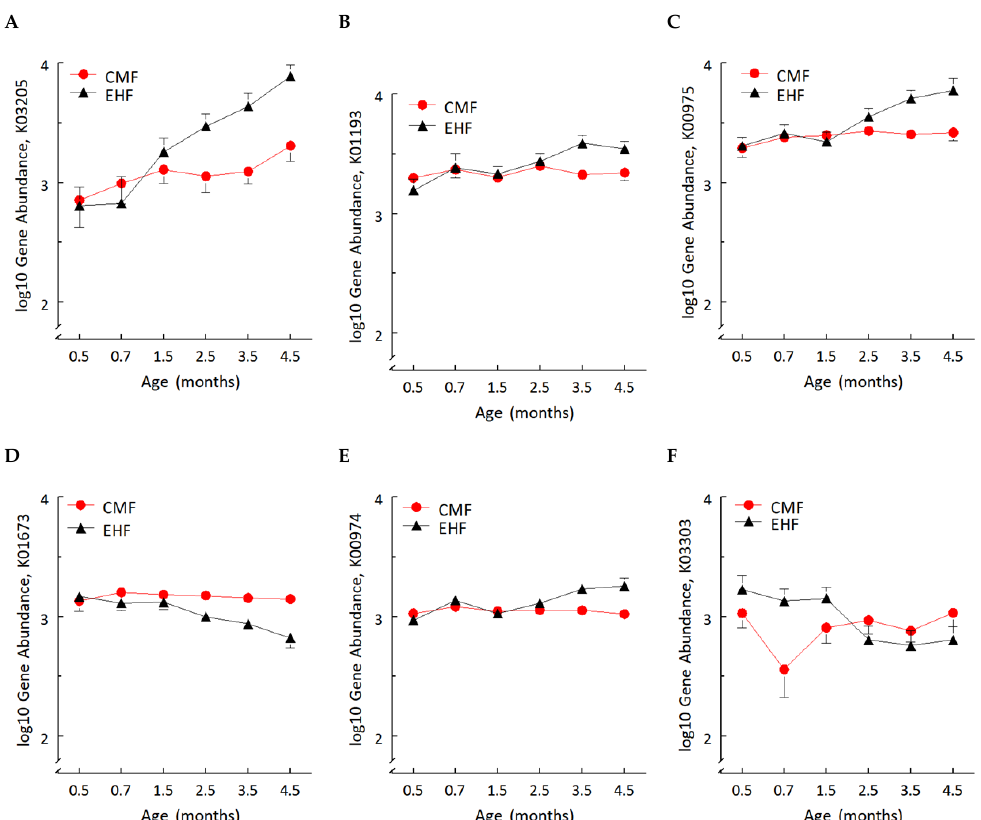
Figure 5. Log 10 gene abundance over time in CMF (red circles) and EHF (black triangles) groups for gene K03205, type IV secretion system protein VirD4 ( A ); K01193, beta-fructofuranosidase ( B ); K00975, glucose 1-phosphate adenylyltransferase ( C ); K01673, carbonic anhydrase ( D ); K00974, tRNA nucleotidyltransferase ( E ); and K03303, lactase permease ( F ). Significant group × time effect for each gene; linear mixed models. 3.3. The Two Groups Shared Similar Fecal Amino Acid Concentrations Despite Different Free Amino Acid Concentrations in CMF and EHF